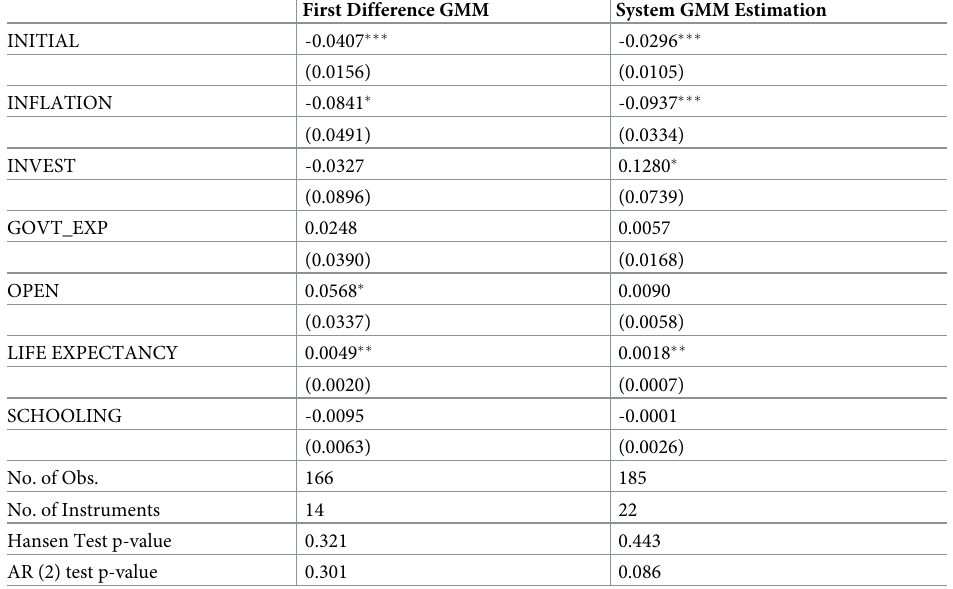
Table 6. Panel GMM results with growth as dependent